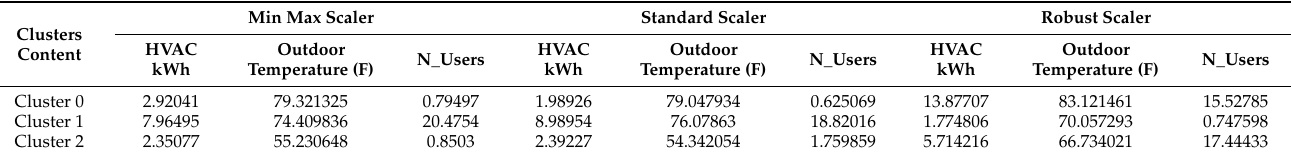
Table 12. Clustering the HVAC consumption, number of users, and outdoor temperature: results. Min Max Scaler Standard Scaler Robust Clusters Content